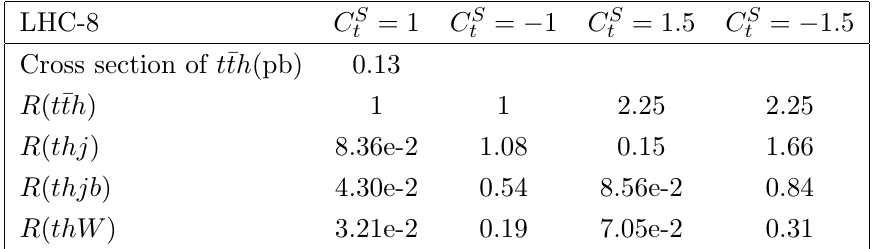
Table 4 . The cross-section ratios R ( t (cid:22) th ) and R ( thX ) with X = j; jb; W de(cid:12)ned in eq. (2.9). We p are taking s = 8 TeV (LHC-8) and C S